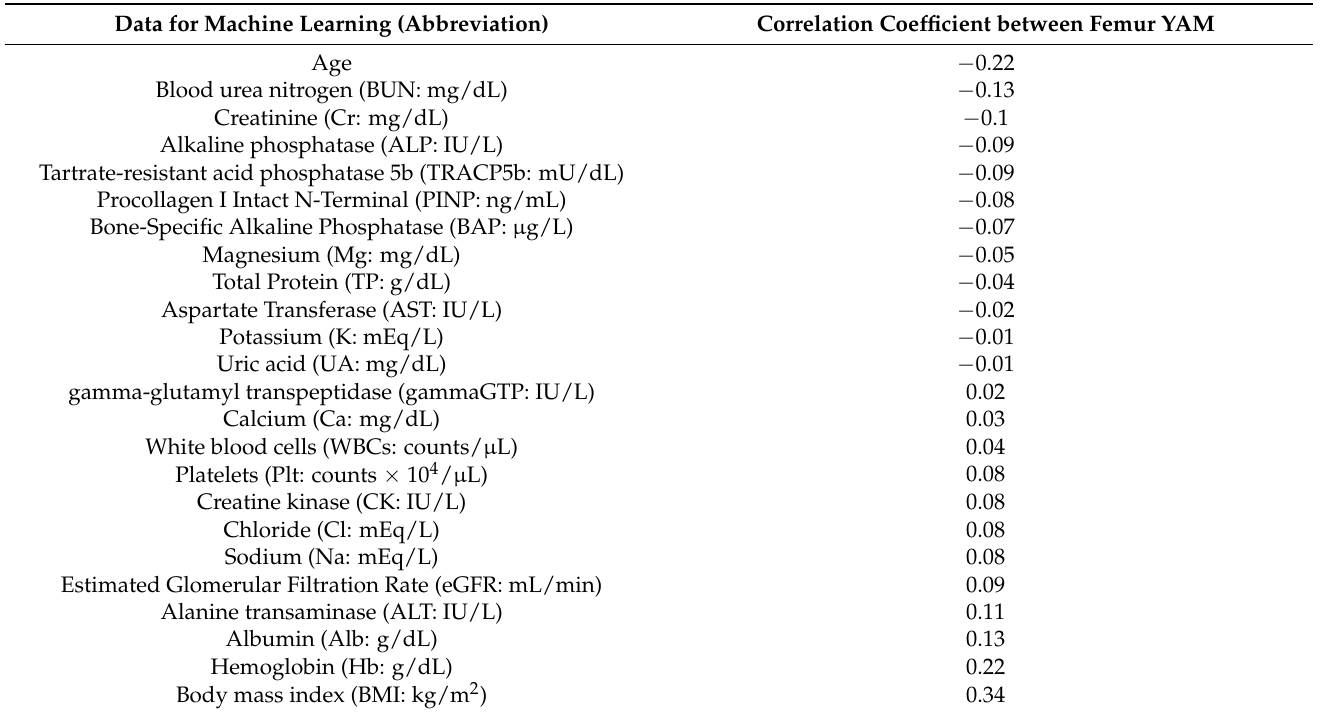
Table 3. The correlation coefficients between femur YAM > 70% and parameters for machine